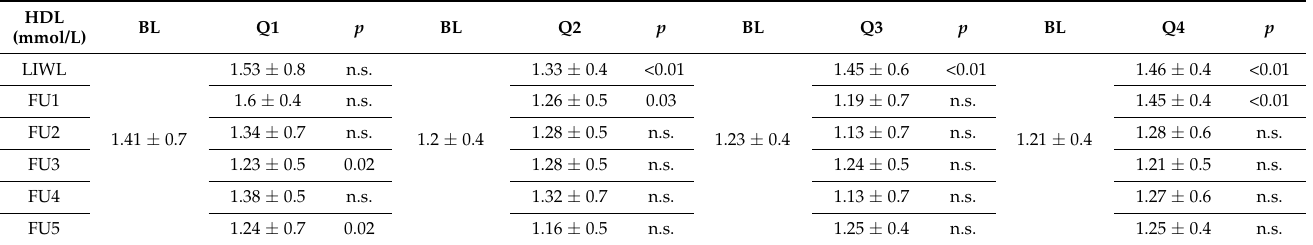
Table 4. Median and interquartile ranges of HDL cholesterol levels before and after LIWL and during the 5-year follow-up.